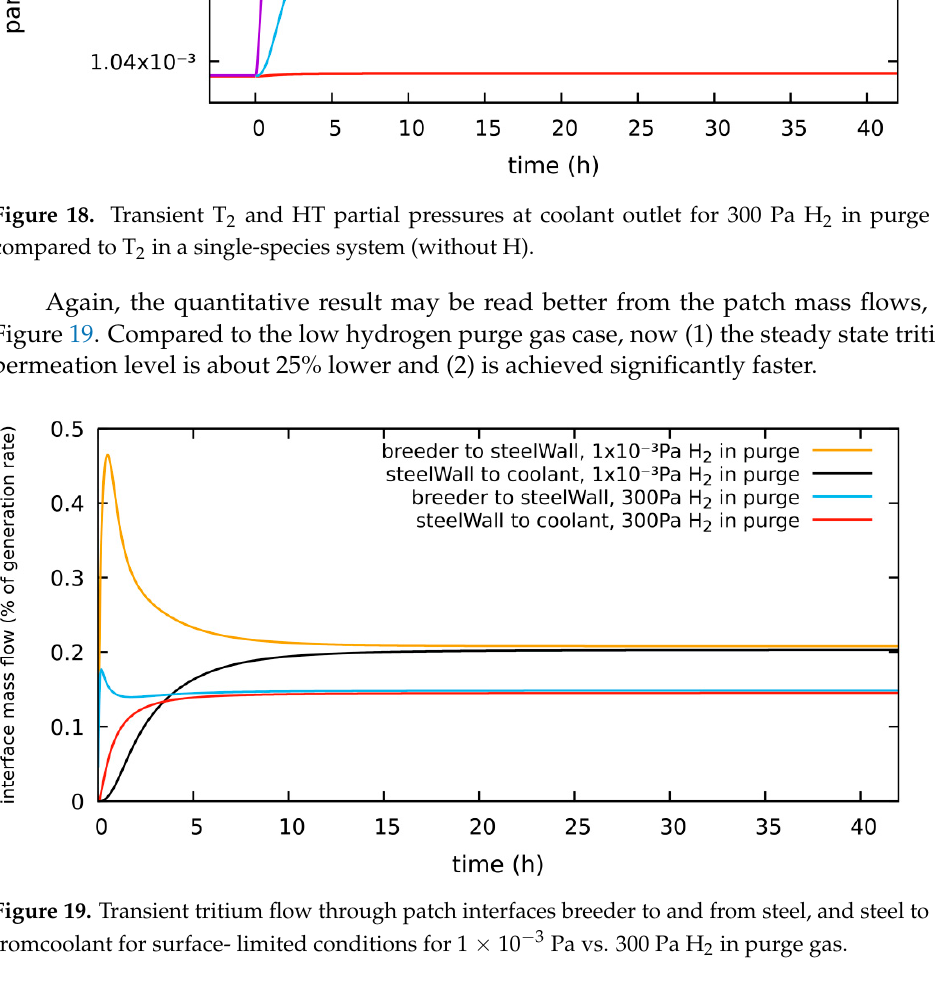
Figure 19. Transient tritium flow through patch interfaces breeder to and from steel, and steel to and fromcoolant for surface- limited conditions for 1 × 10 − 3 Pa vs. 300 Pa H 2 in purge gas. The transient tritium inventory in the steel wall that separates breeder and coolant approaches a steady-state value of 0.19 μ g/pin. All observations might be compiled to-